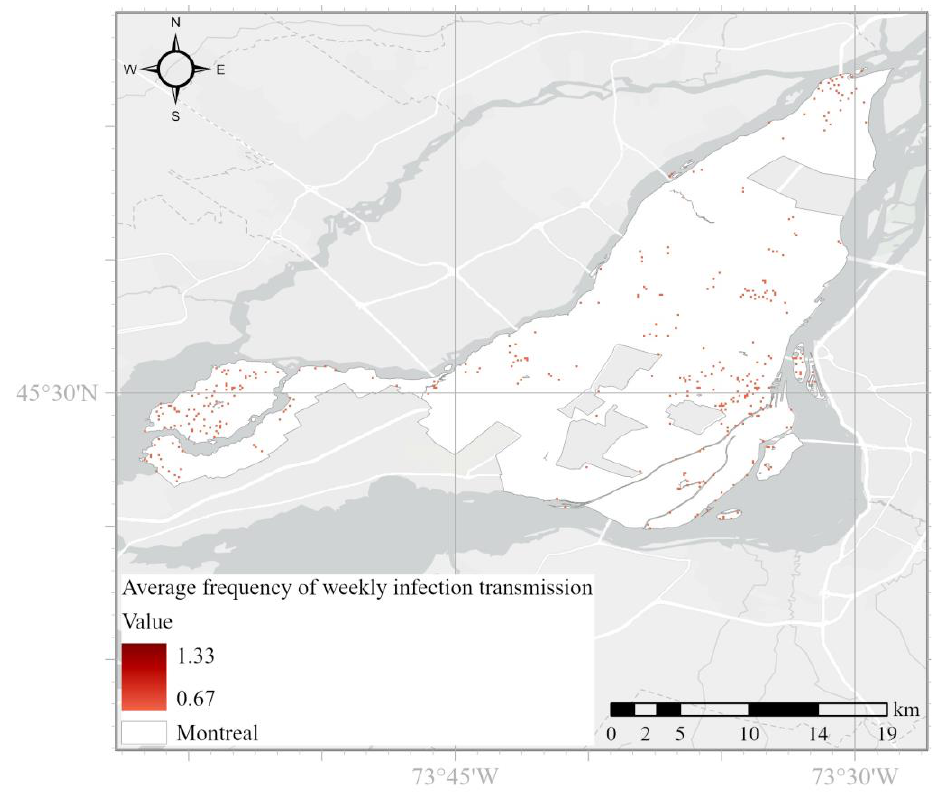
Figure 8. The spatial map of critical locations of COVID-19 spreading in the study area.